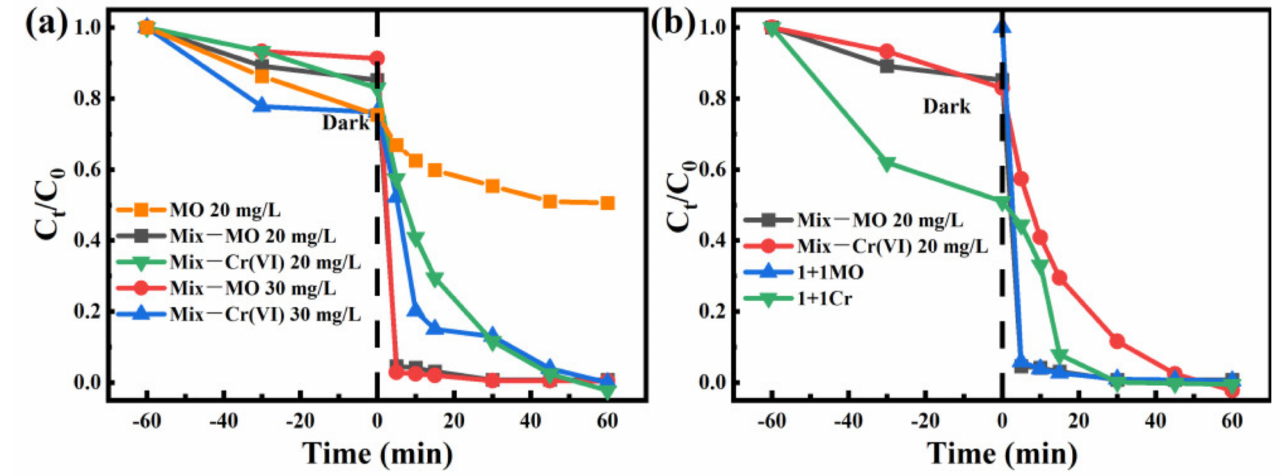
Figure 8. ( a ) Removal efficiencies of MO and Cr(VI) in mixture solution contained MO and Cr(VI); ( b ) The effect of MO addition type on Cr(VI) degradation, the sign of “Mix” indicates that MO and Cr(VI) was added into the solution at the same time, the sign of “1 + 1” indicates that MO was added into the Cr(VI) solution after a 60-min dark